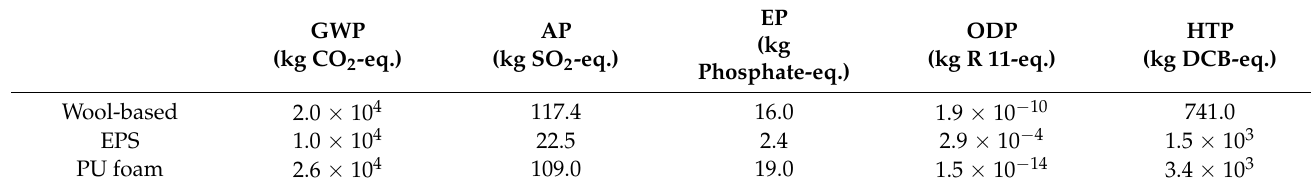
Table 4. Cradle-to-gate (manufacturing phase).